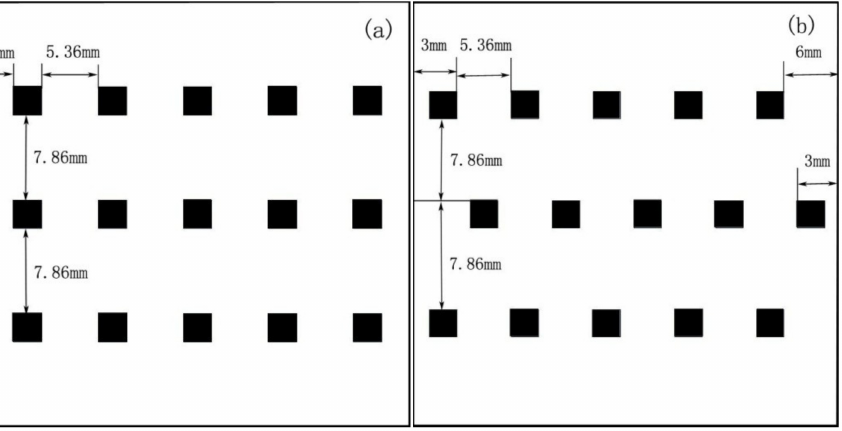
Figure 10. ( a ) Model diagram of a rectangular array; ( b ) model diagram of a diamond